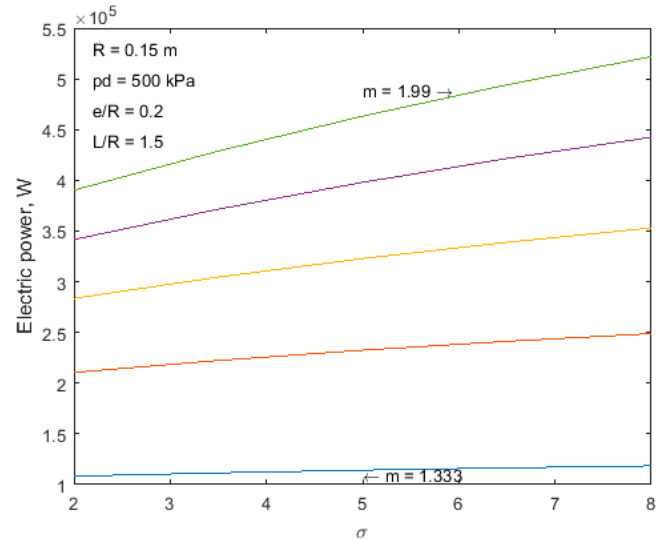
Figure 13. Electric power versus σ = p s / p d for different polytropic exponents ( m) , m = 1.333 (blue line), m = 1.4973 (red line), m = 1.6615 (orange line), m = 1.8258 (violet line), m = 1.99 (green line).